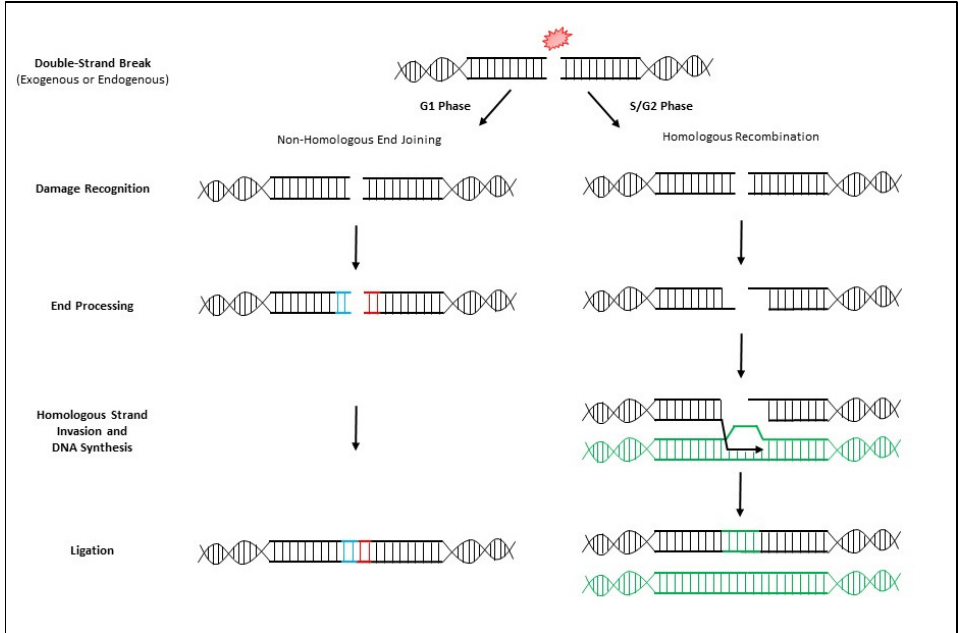
Figure 3. Basic Mechanisms of Classical Non ‐ Homologous End Joining (NHEJ) ( Left ) and Homologous Recombination (HR) ( Right ). Classical NHEJ is predominantly initiated when a DNA double ‐ strand break (DSB) occurs in G1. The MRN complex in cooperation with other proteins binds the damaged DNA, tethers the broken ends together for end processing, priming and ligation. This process is often error ‐ prone and often results in the permanent loss of bases at the DSB site. A DSB in S or G2 most often initiates HR and relies on the presence of a homologous sister chromatid of DNA to prevent loss of genetic information. The DSB is identified by the MRN complex which initiates 5 ′ end resection. The resulting 3 ′ single ‐ stranded overhang is bound by proteins and invades the homologous strand of DNA and initiates DNA synthesis. This results in no loss of genetic